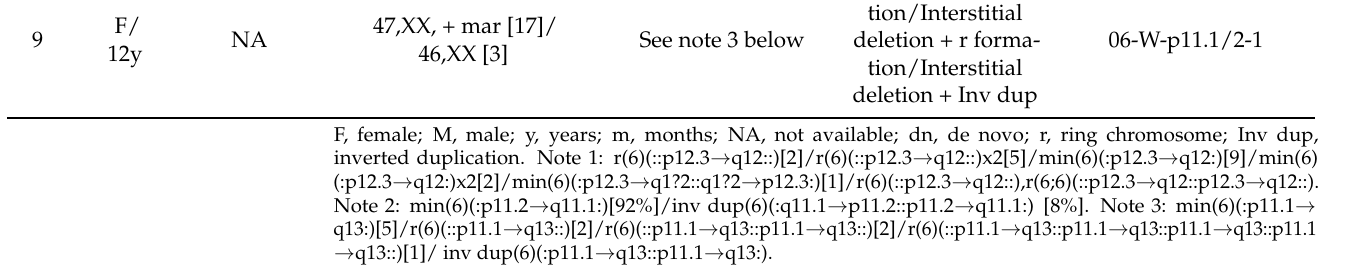
Table 2. Comparison of cases with clinical findings associated with neocentric sSMC(6).